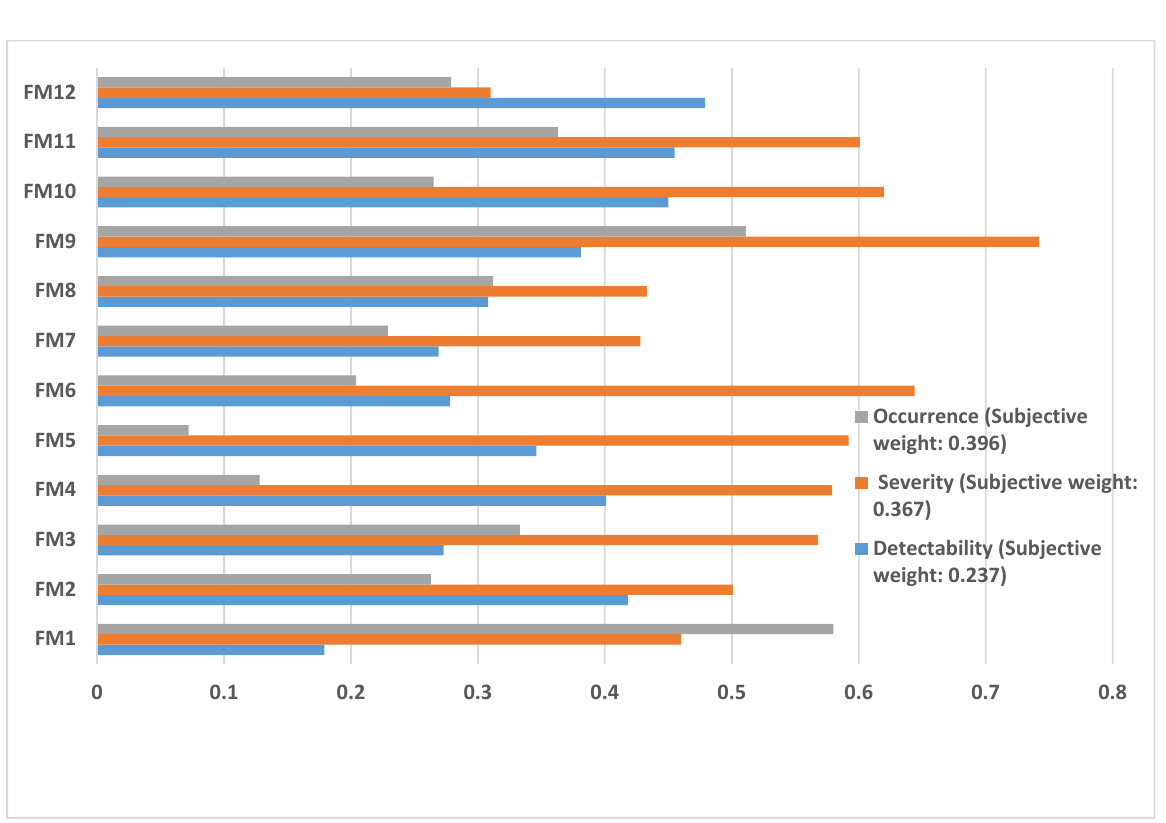
Figure 5. Defuzzified crisp values for 12 failure modes.